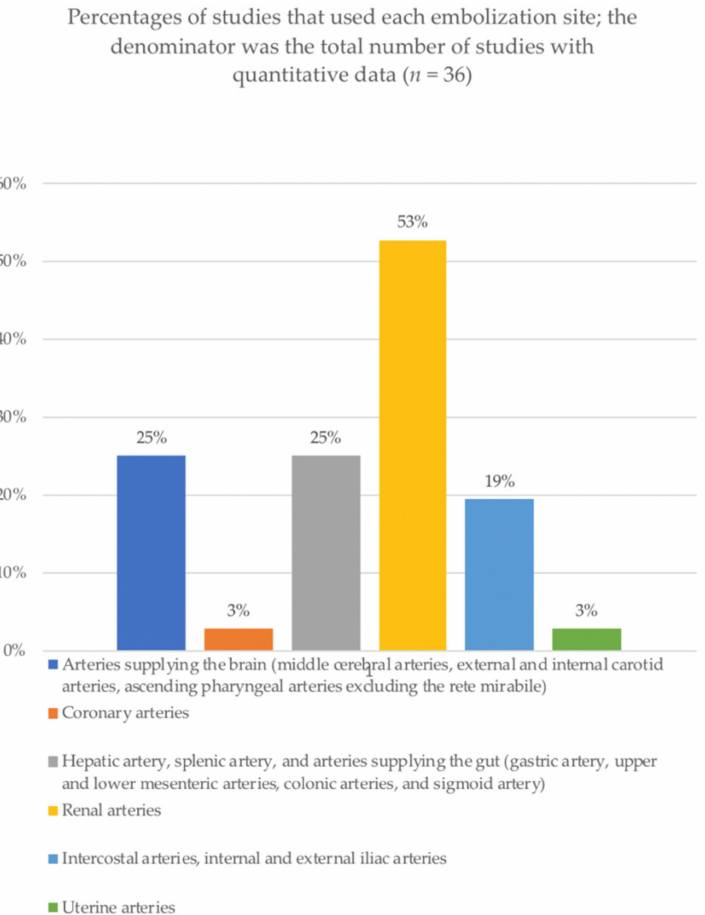
Figure 4. Percentages of studies that used each embolization site; the denominator was the total number of studies with quantitative data ( n =